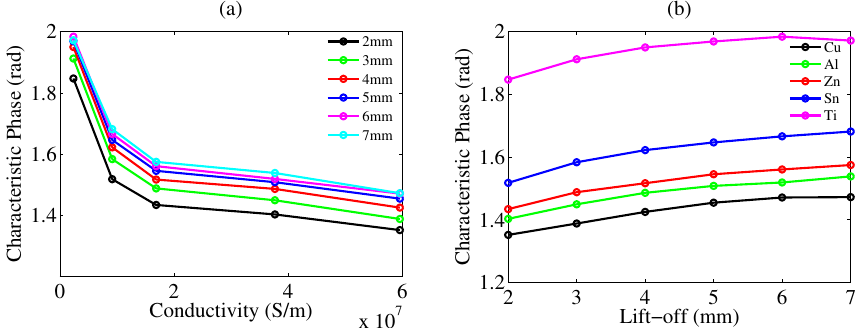
Figure 5. ( a ) Characteristic phase versus metals, where black diamond denotes 0 ◦ , green diamond denotes 2.86 ◦ , red diamond denotes 5.71 ◦ , blue diamond denotes 8.53 ◦ and magenta diamond denotes 11.31 ◦ . ( b ) Characteristic phase versus angles where black diamond denotes copper, green diamond denotes aluminum, red diamond denotes zinc, blue diamond denotes tin and magenta diamond denotes titanium.